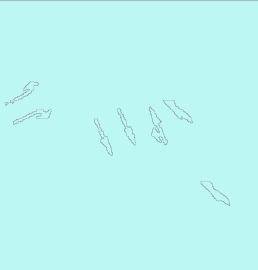
Figure 9. Sample resulting polygon shapefile.